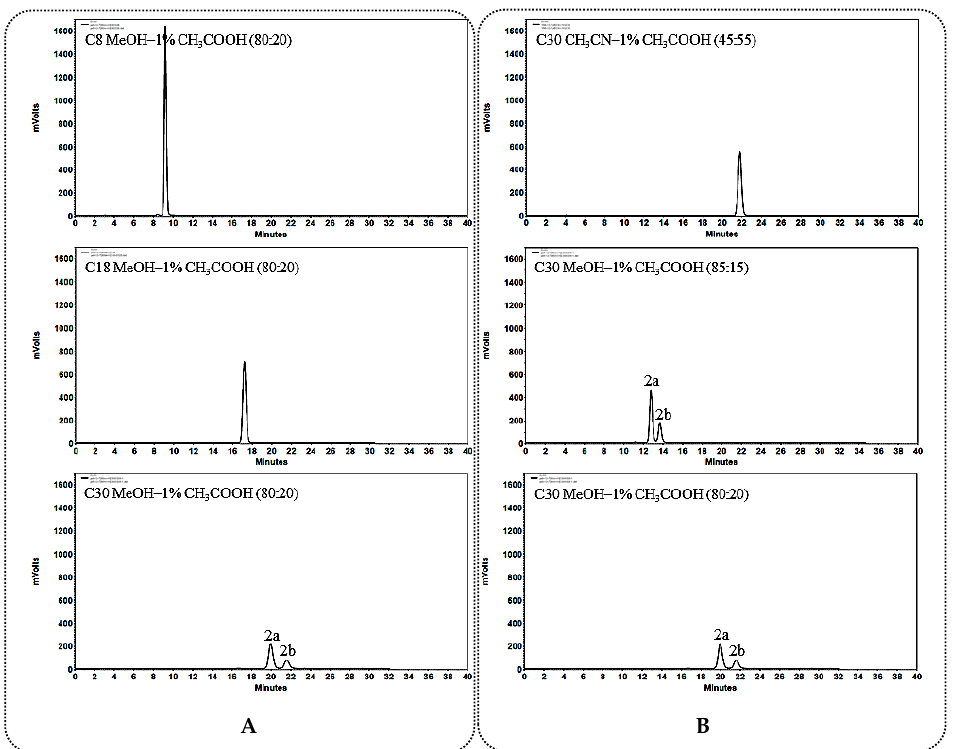
Figure 3. ( A ) Chromatograms of 2a and 2b separated on C 8 , C 18 , C 30 columns; ( B ) Chromatograms of 2a and 2b separated on the C 30 column in different solvent systems.